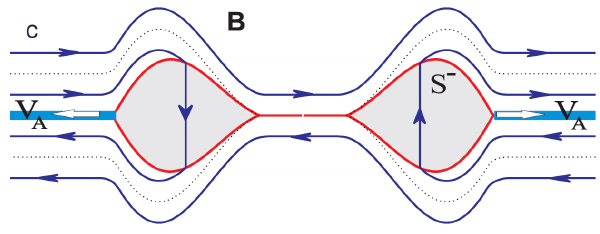
Fig. 1. Time-dependent Petschek-type reconnection model: Cur- rent sheet separating two plasma domains with opposite magnetic fields B decays into a system of MHD discontinuities and shocks S , which form two outflow bulges propagating in opposite directions with the Alfv´en speed V A . The dotted line is a separatrix between the reconnected magnetic flux and the non-reconnected one. The shaddowed area represents outflow bulges